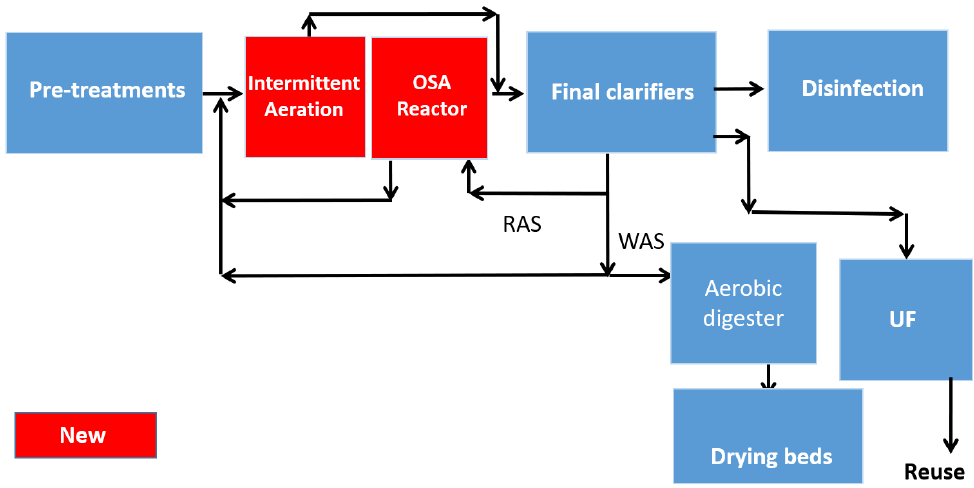
Figure 2. CAS-OSA full-scale plant configuration.